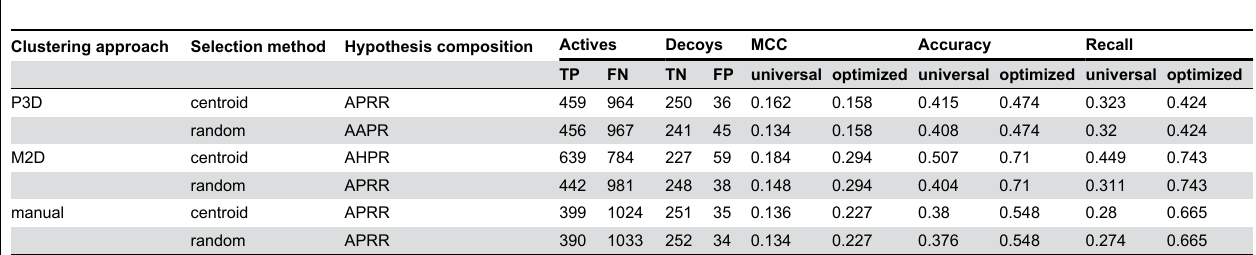
Table 2. A comparison between a single hypothesis and a linear combination of pharmacophore